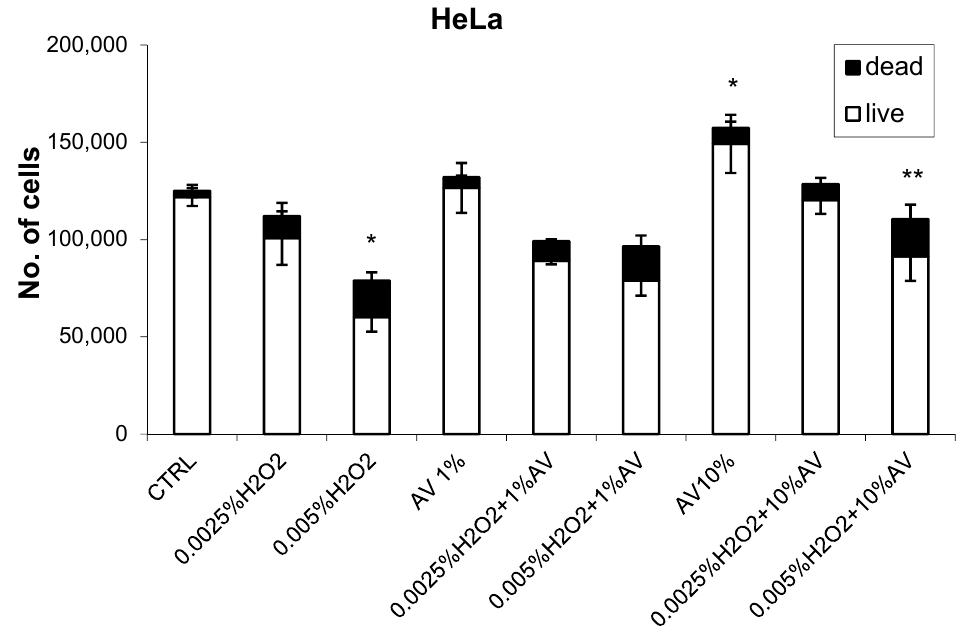
Figure 2. The effects of Aloe vera (AV) extract (1 or 10%) on the human cervical cancer (HeLa) cells with respect to H 2 O 2 treatment (0.0025% or 0.05%). The cell count values (viability determined using Trypan blue) were obtained 24 h after treatment (H 2 O 2 followed by AV extract 1 h later) and are given as mean values for triplicates. * significant difference to untreated control; ** significant difference to H 2 O 2 treatment alone.